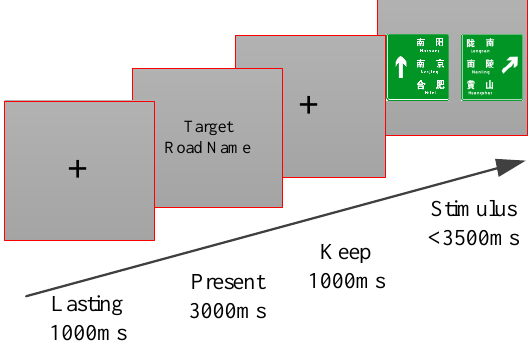
Figure 2. Procedure diagram of the test stimulus.